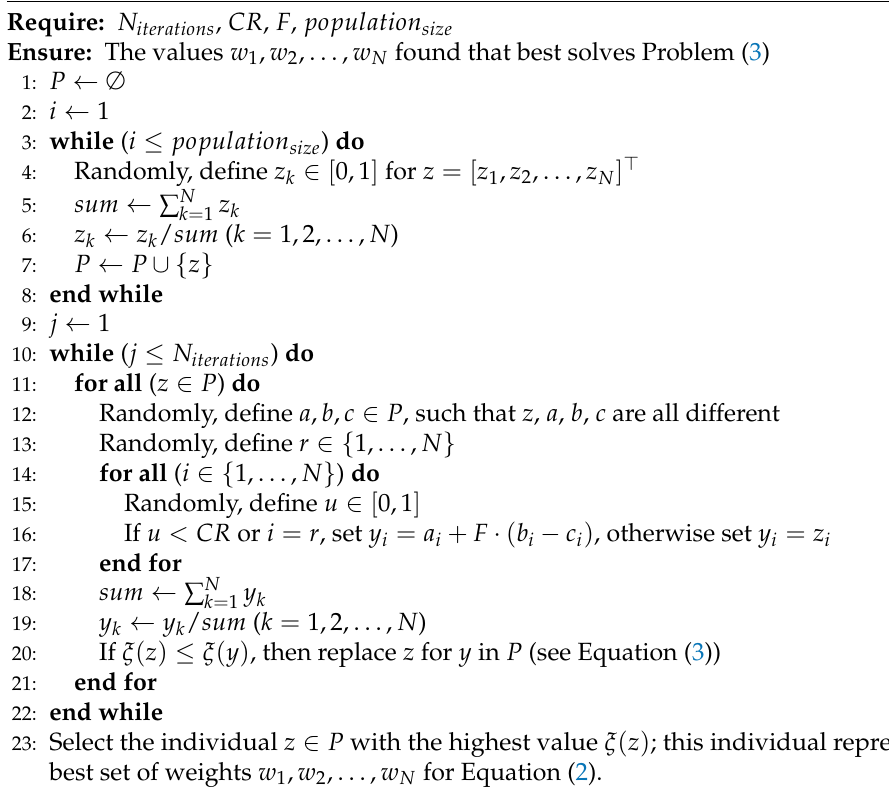
Algorithm 1 Differential evolution used to address Problem